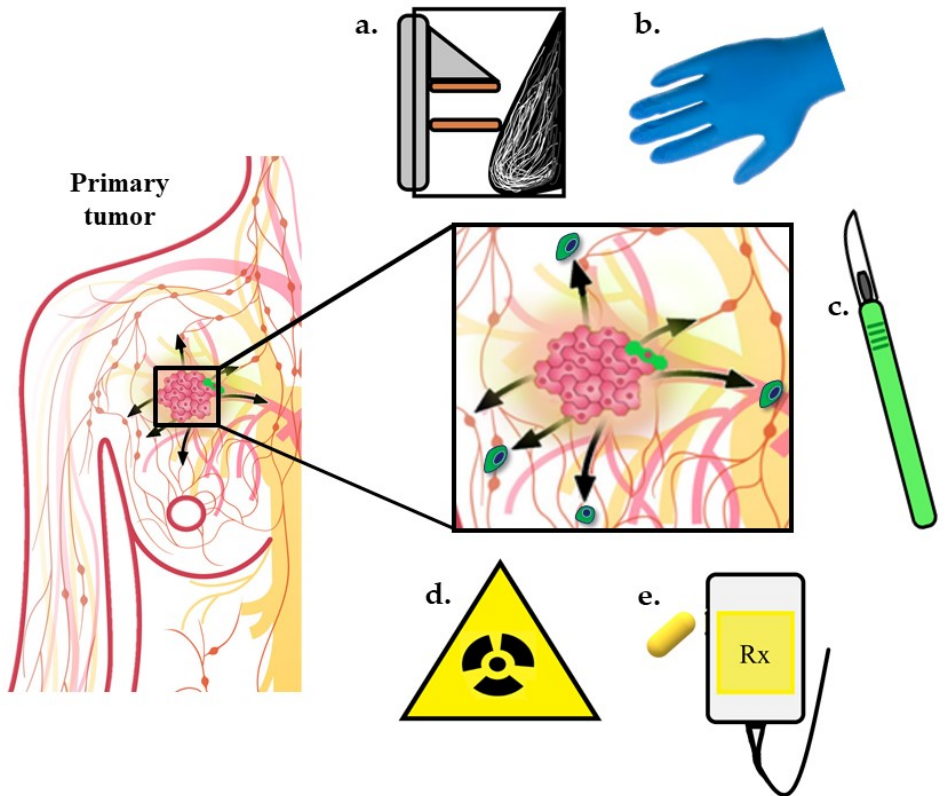
Figure 2. All current treatment modalities have the potential to promote CTCs. Early studies have shown that pressure such as that from mammograms ( a ) and tumor palpations ( b ) may promote tumor cell release. Surgical procedures ( c ) including biopsies and complete tumor resections can promote CTCs. Other possible primary tumor curative treatments such as radiotherapy ( d ) and chemotherapy ( e ) may inadvertently increase CTCs. Figure adapted from nationalbreastcancer.org [85] .